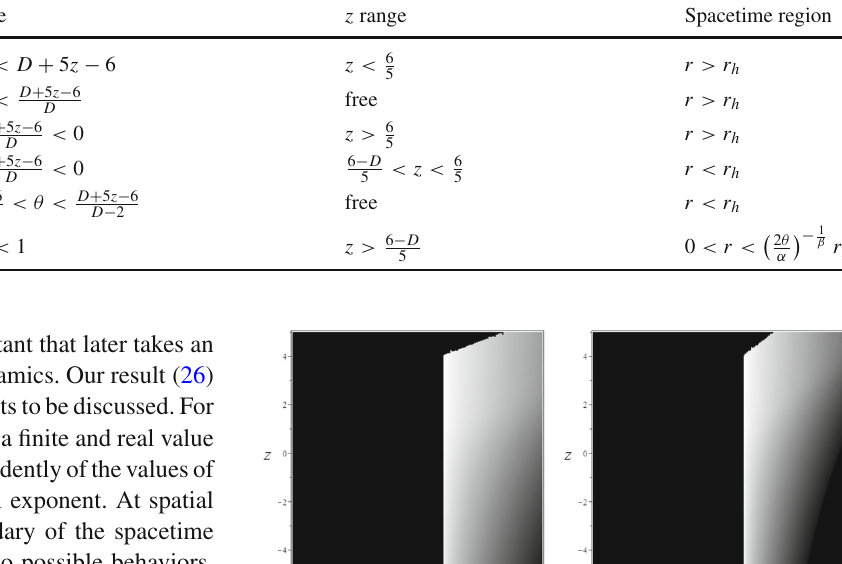
Table 2 Different regions of spacetime, determined by a range on r , where the scalar field is real and thus physically sensible depending on relations between the (θ, z , D )